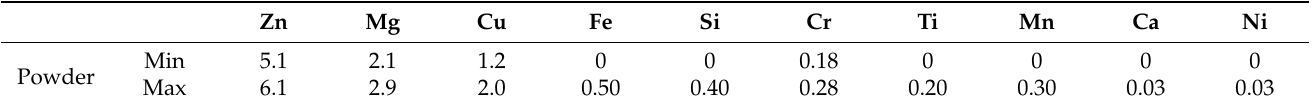
Table 1. Chemical composition (wt %) of Al7075